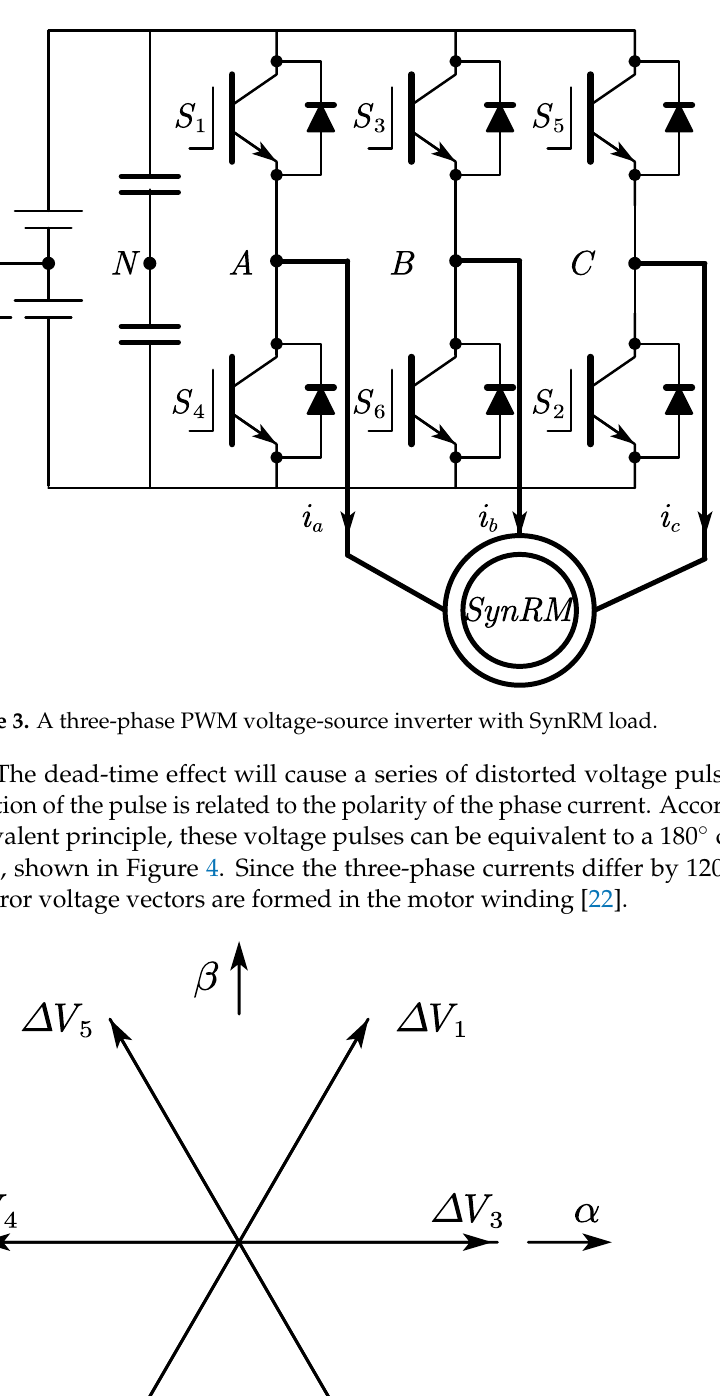
(11) It is clear that the amplitude of harmonic voltage is inversely proportional to the har- monic order. Sensorless position estimation based on filter-free HF square-wave injection needs to obtain HF current signal in αβ frame. In αβ frame, the major harmonic compo- nents are 1st, 5th, and 7th order harmonics. The separation of high-frequency signals is